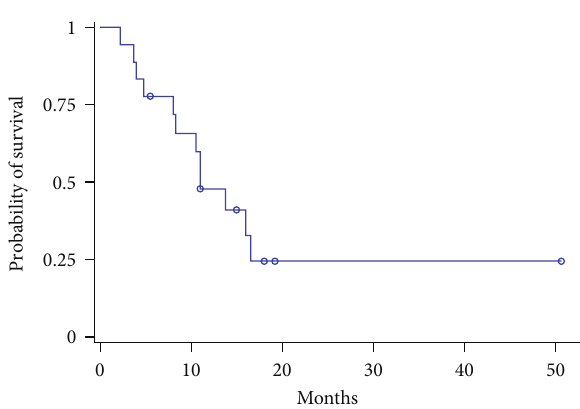
Figure 2: Kaplan-Meier analysis of overall survival (months): medi- an overall survival not reached ( 95 % CI, 9.0– ∞ ) aften mean follow- up of 13.0 months.